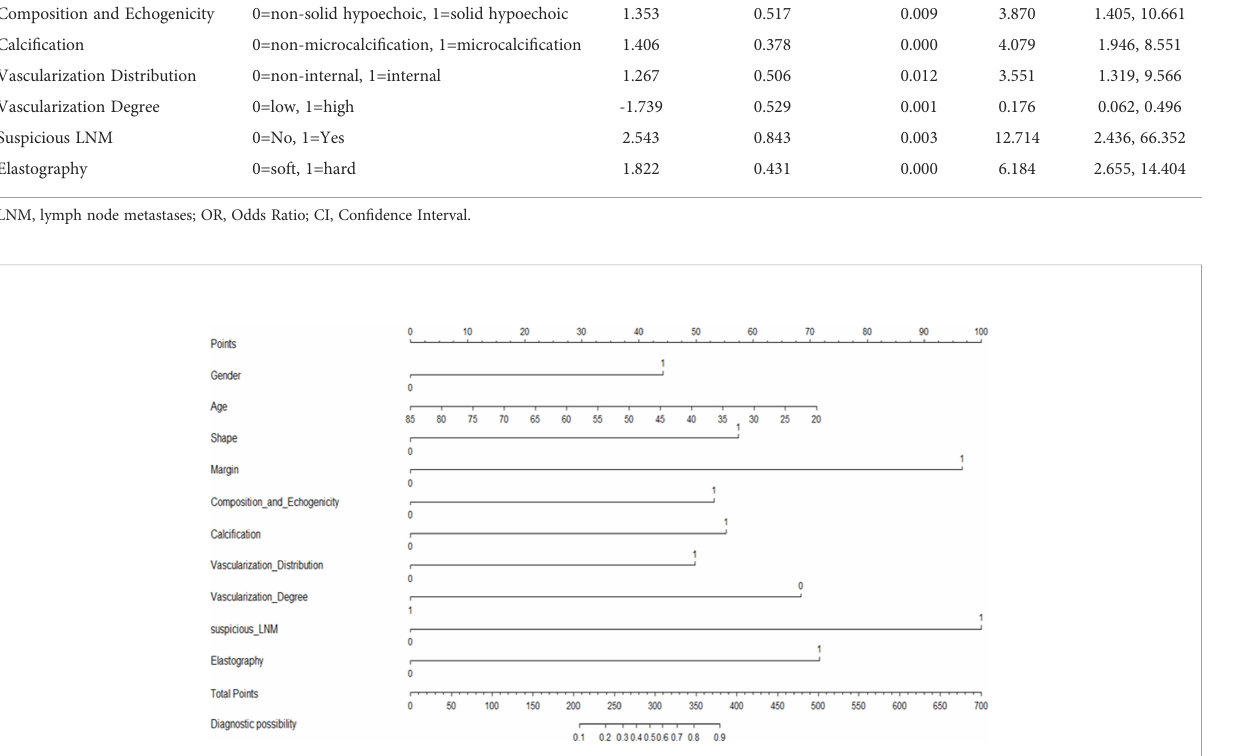
FIGURE 2 A CBCE nomogram to predict the malignancy probability of thyroid nodules based on clinical, B-mode, Color Doppler and elastographic ultrasonographic characteristics.